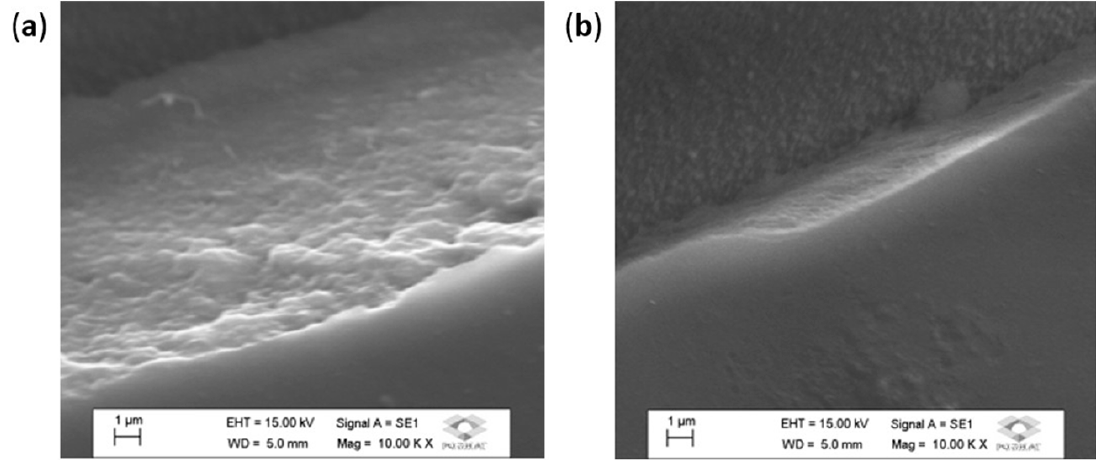
Fg − 1 [9]. Such a difference is most likely due to the different state of the electrolyte, i.e., wet